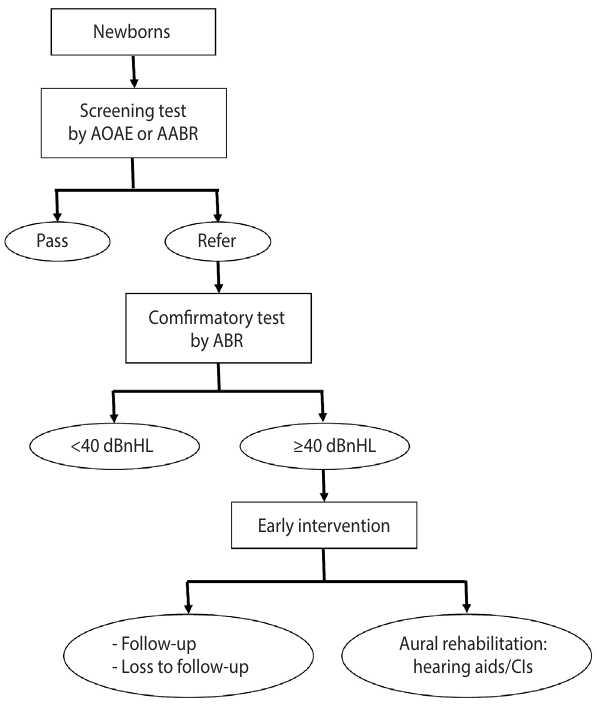
Figure 1. Flow chart of newborn hearing screening in Daegu, Gyeo- ngbuk and Ulsan (2011-2015). AOAE, automated otoacoustic emis- sion; AABR, automated auditory brainstem response; ABR, auditory brainstem response; dBnHL, decibel normal hearing level; CIs, coch- lear